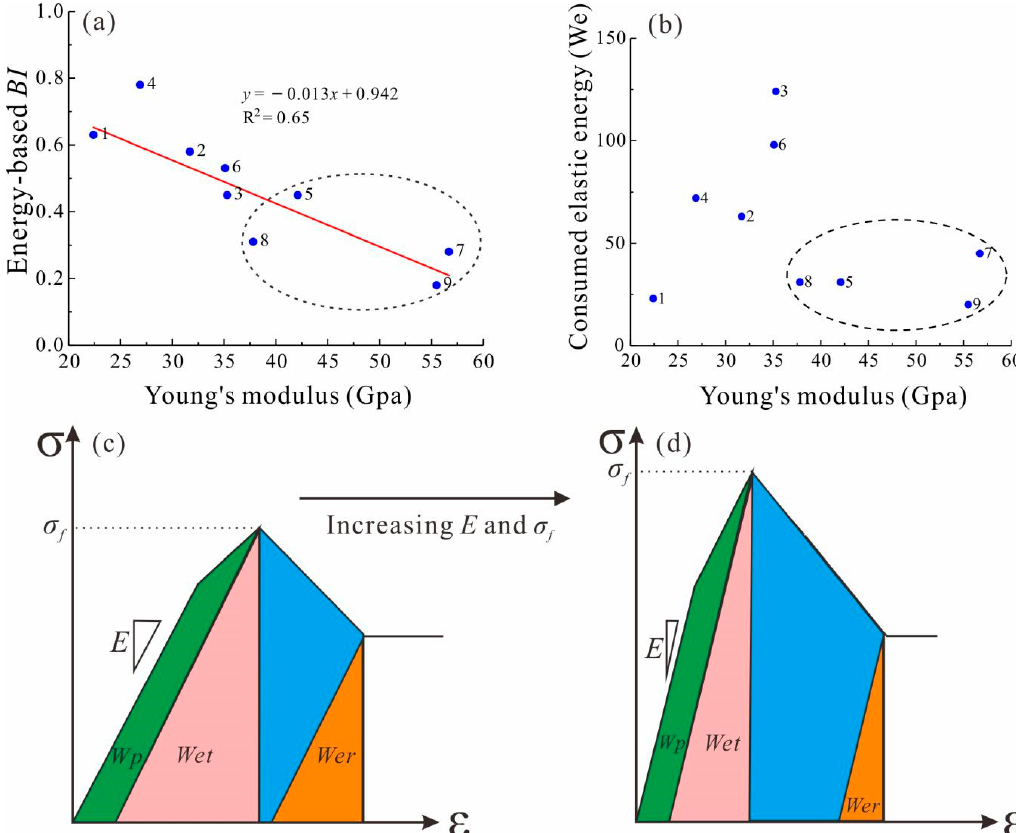
Figure 6. The relationship between brittleness index and Young’s modulus. ( a ) A negative correlation of Young’s modulus and energy-based BI ; ( b ) Samples 5, 7, 8, and 9 with higher Young’s modulus consume less elastic energy ( We, the difference between Wet and Wer ); ( c , d ). The change of energy with the increase of Young’s modulus and peak strength ( σ f ). Wp (plastic energy), Wet (total elastic energy), Wer (residual elastic energy).